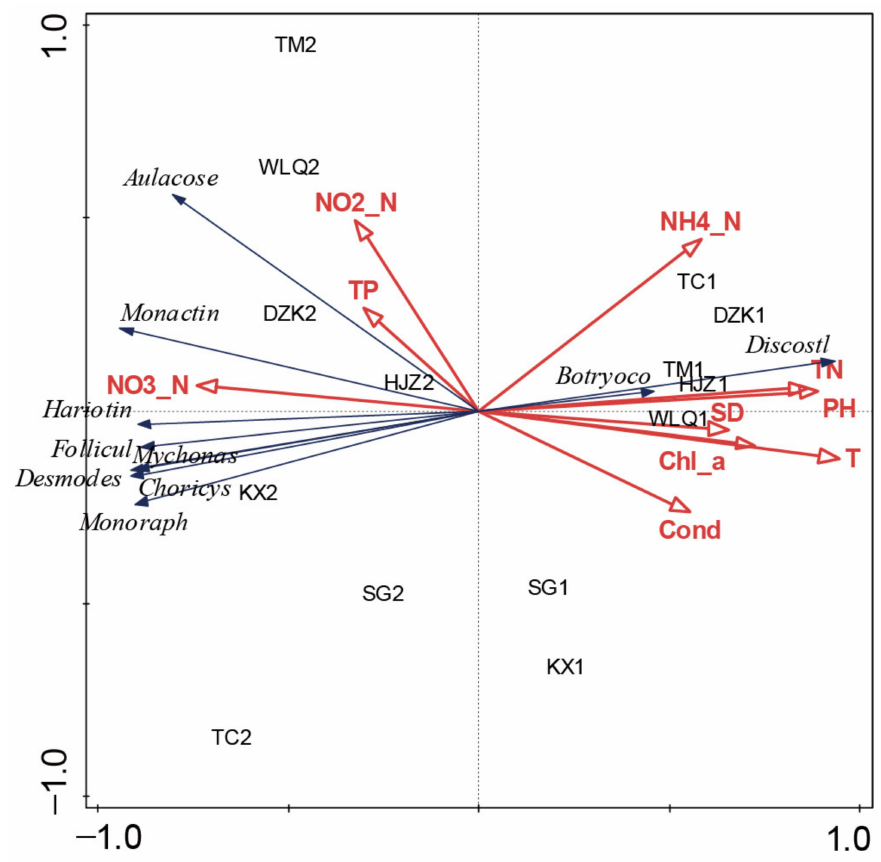
Figure 6. RDA diagram of dominant diatom genera and environmental factors in the Danjiangkou Reservoir (1 is spring, 2 is summer, 3 is autumn, and 4 is